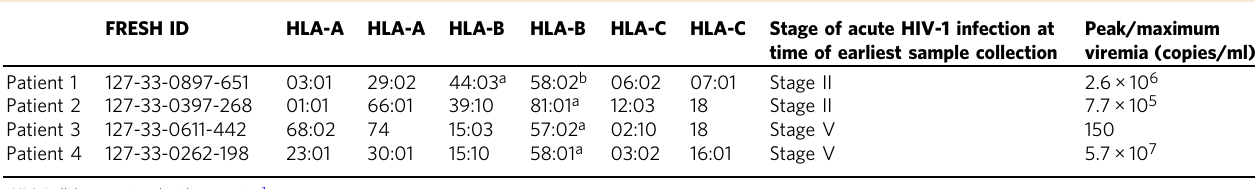
Table 1 Clinical and immunogenetic characteristics of study patients FRESH ID HLA-A HLA-A HLA-B HLA-B HLA-C HLA-C Stage of acute HIV-1 infection at